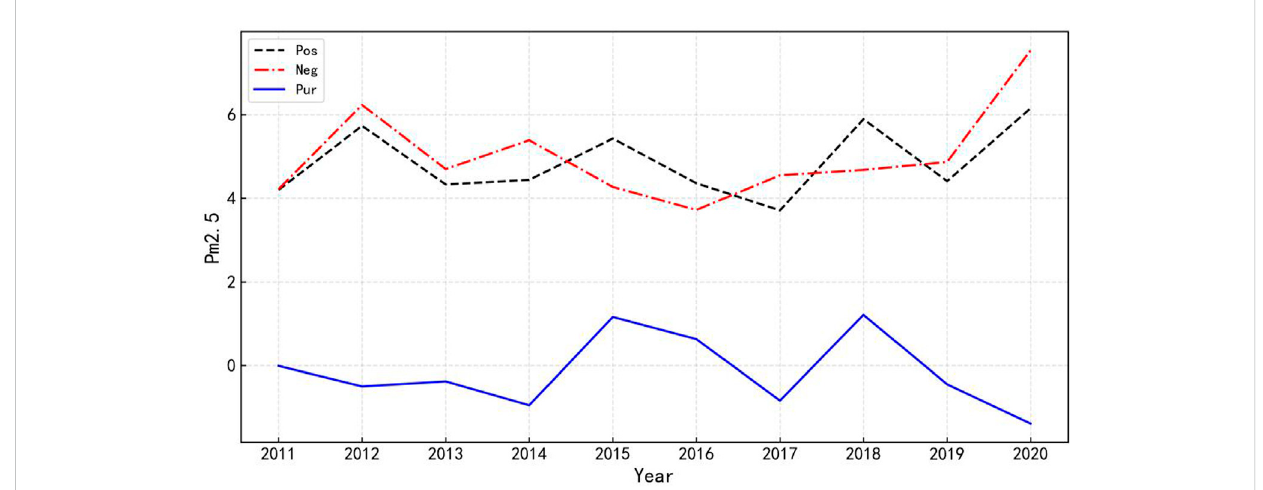
FIGURE 3 Characteristics of the annual distribution of the net effect of the digital economy on air pollution (%). Note: Pos indicates the emissions increase effect; Neg indicates the emissions reduction effect; and Pur indicates the net effect.